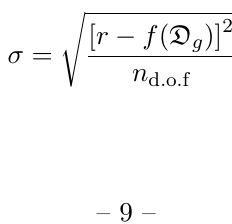
( x , x 0 ) , computed with the g = ∆ CB , the most accurate estimate. φ φ